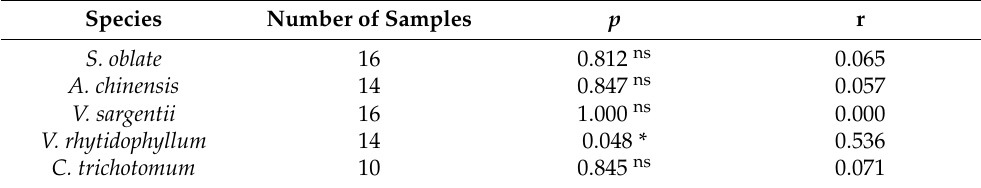
Table A1. Correlations between leaf Nmass and leaf protein concentration for five plants derived from the third sampling campaign.